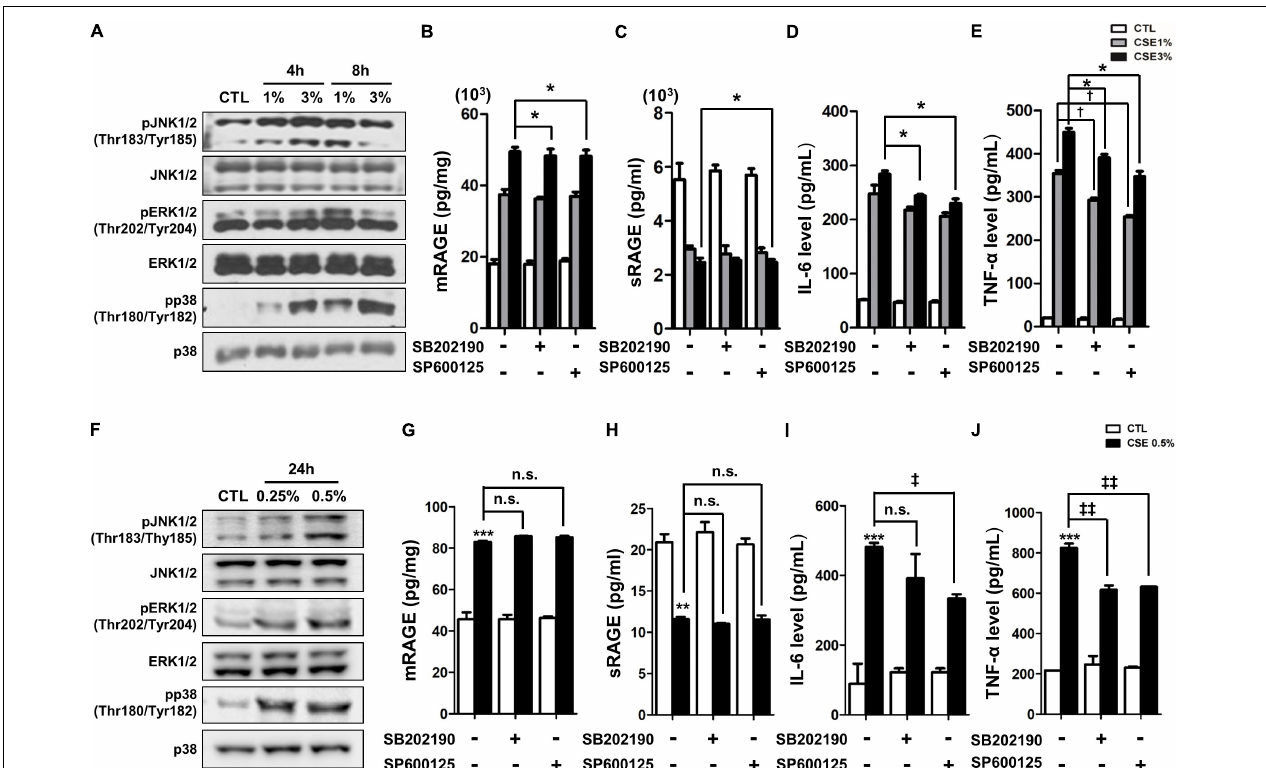
FIGURE 3 | The inhibitory effect of MAPK pathway on CSE-induced alternation of RAGE distribution and inflammation in human alveolar epithelial cells. (A) Time and concentration course of MAPK activities in CSE-exposed A549 cells were determined by western blotting of the phosphorylated JNK1/2 (Thr183/Tyr185), ERK1/2 (Thr202/Tyr204), and p38 (Thr180/Tyr182) MAPK. Equal protein loading amounts were proved by β -actin expression. The corresponding density ratio was determined by the average intensity of the bands. The results are represented by average value of data ( ± SE). ∗ p < 0.05, ∗∗ p < 0.01, and ∗∗∗ p < 0.001 vs. CTL. The A549 cells were pretreated with 30 µ M SB202190 or SP600125 for 2 h, and then incubated with 1–3% CSE for 8 h. The levels of (B) mRAGE in cell lysate and (C) secreting sRAGE in culture supernatants of cell after CSE exposure were detected by ELISA analysis. The protein levels of (D) IL-6 and (E) TNF- α were examined by ELISA analysis. The MLE12 cells were pretreated with 20 µ M SB202190 or SP600125 for 2 h, and then incubated with 0.25% or 0.5% CSE for 24 h. (F) The MAPK activities were determined by western blotting, and the level of (G) mRAGE in cell lysate, (H) secreting sRAGE in culture supernatants of cells and the level of (I) IL-6 and (J) TNF- α were detected by ELISA analysis. The data showed that MAPK inhibition reversed CSE-induced release of pro-inflammatory cytokine, whereas it failed to reverse abnormal RAGE expression by CSE. The results are represented by average value of data ( ± SE). † p < 0.05, as compared with the cells